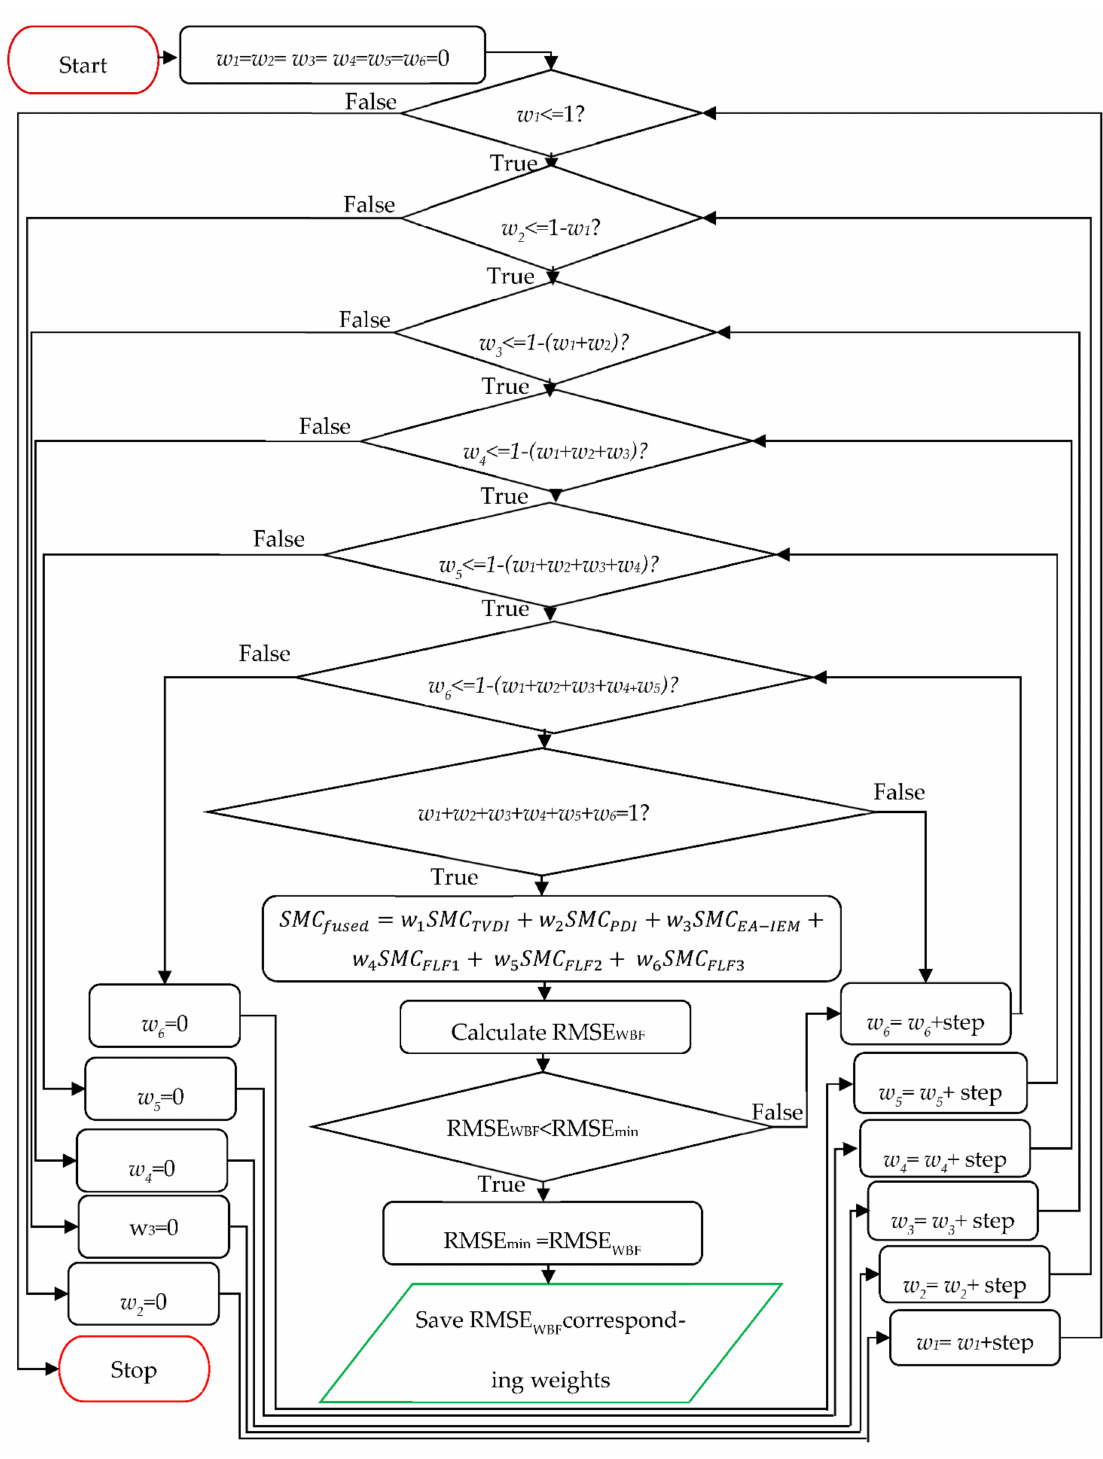
Figure 5. Flowchart of the fusion